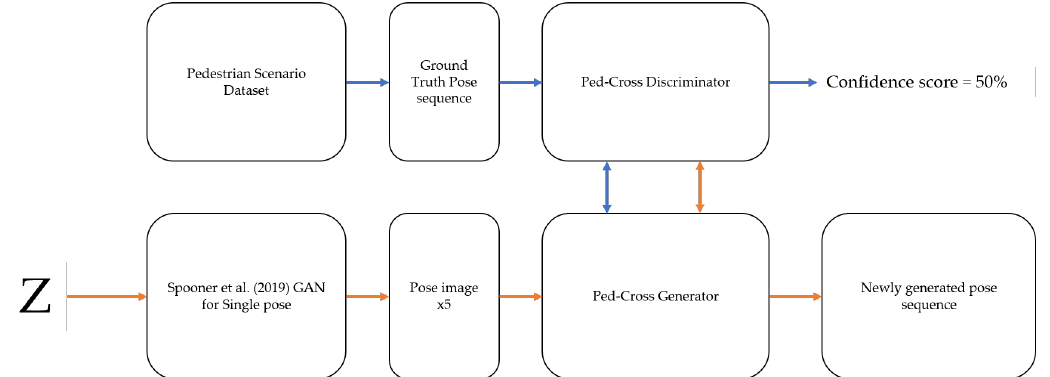
Figure 5. Schematic of Ped-Cross Generative Adversarial Networks